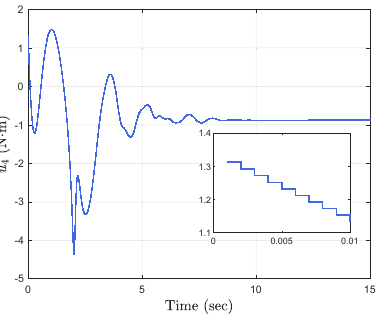
Figure 14. Time − triggered control input u 3 .